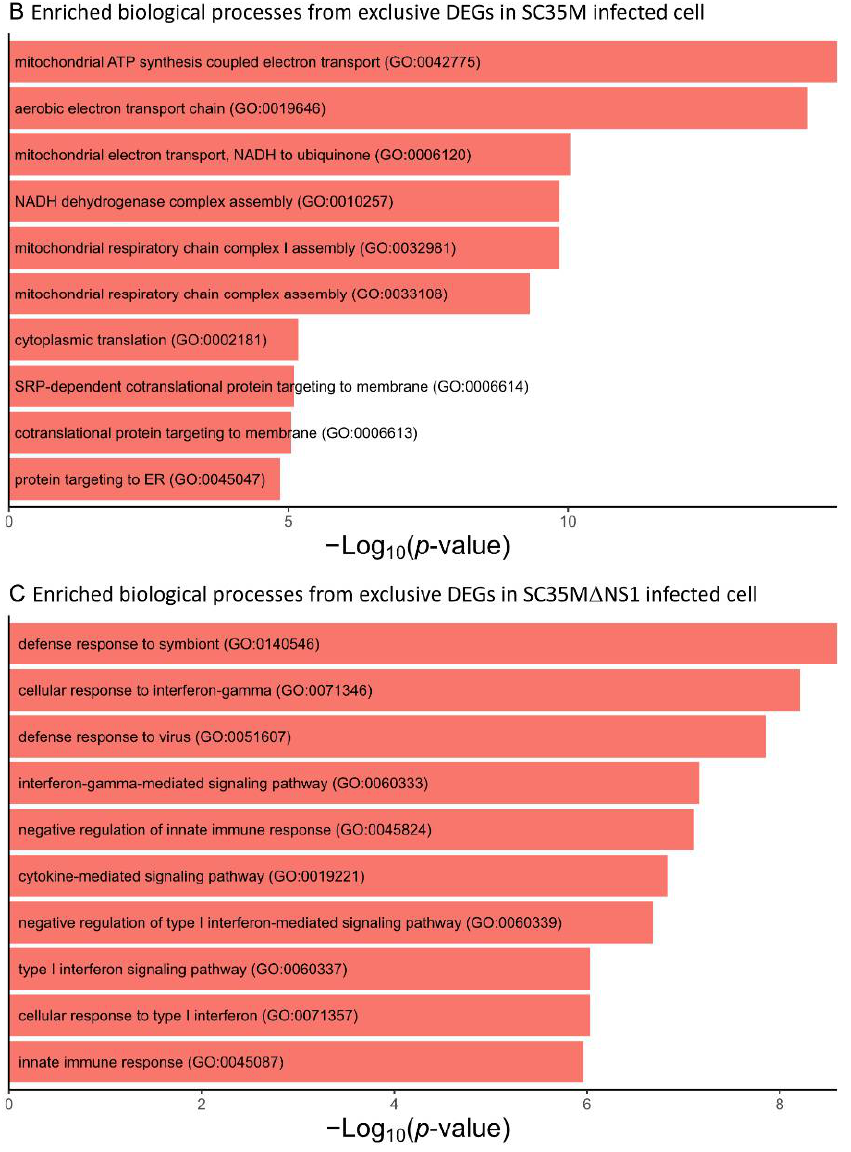
Figure A3. Top 10 most significantly enriched biological process GO terms associated with the genes exclusively differentially expressed in ( A ) PR8M infected cells, ( B ) SC35M infected cells, ( C ) SC35MΔNS1 infected cells. The terms are ranked according to the p -value.